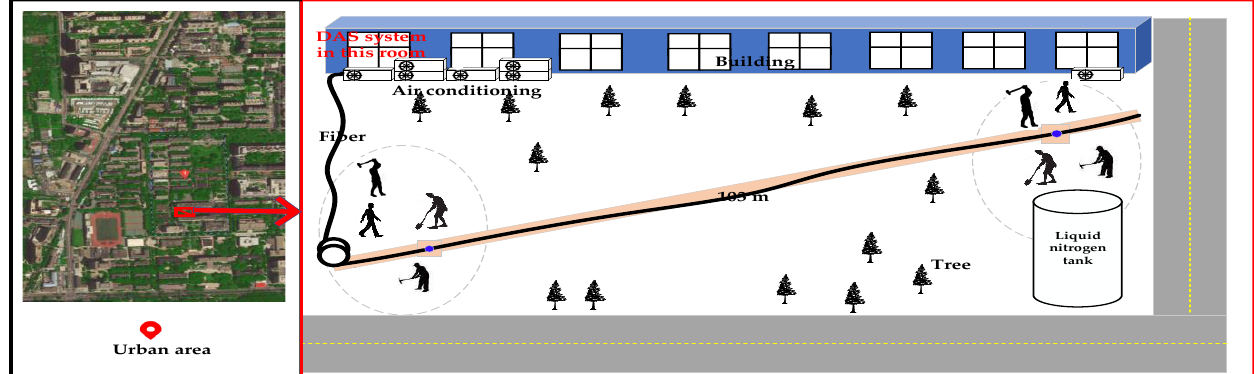
Figure 6. The field experiment in the Beijing urban environment.